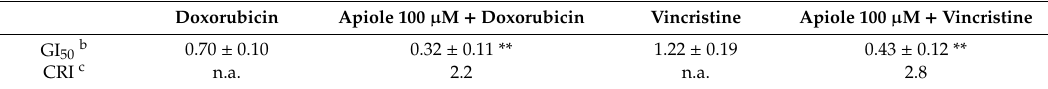
Table 5. Antiproliferative activity a expressed as GI 50 b ( µ M) of doxorubicin, vincristine, and their associations with apiole against the ovarian adenocarcinoma cell line OVCAR-3 after 48 h exposure.